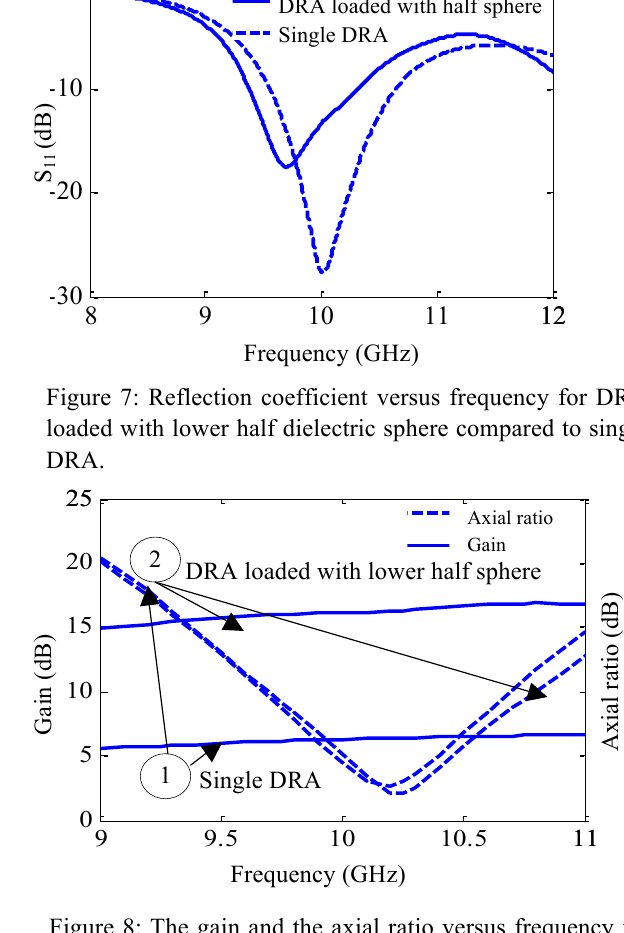
Figure 8: The gain and the axial ratio versus frequency for DRA loaded with lower half dielectric sphere compared to a single